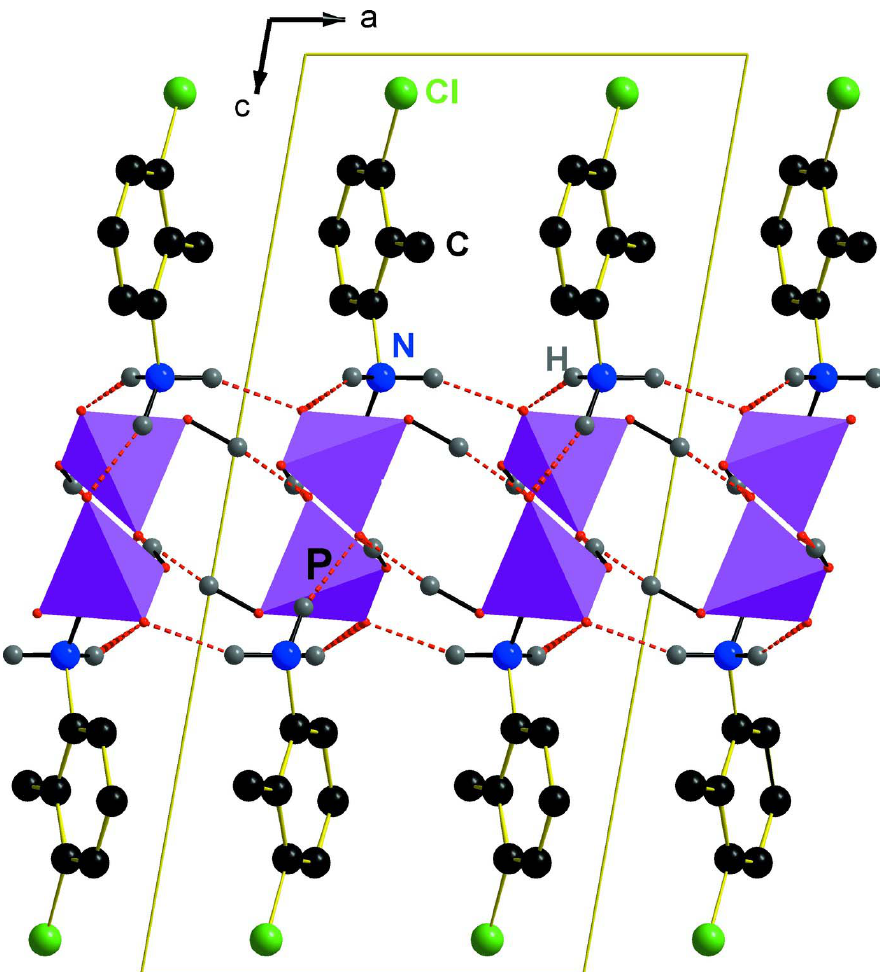
Figure 3 Projection of (I) along b axis. 3-Chloro-2-methylanilinium dihydrogenphosphate Crystal